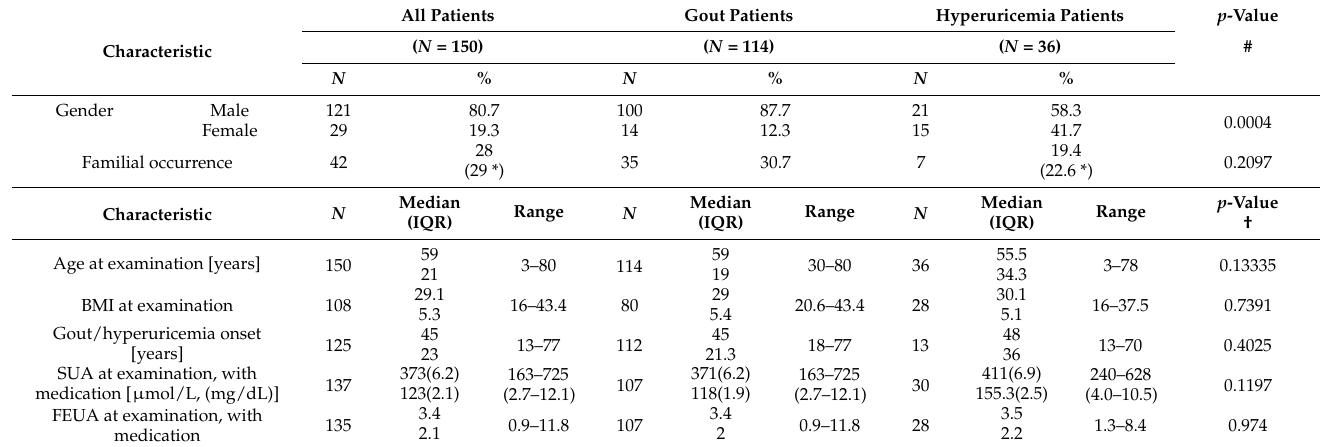
Table 2. The main demographic and biochemical characteristics of the subjects.